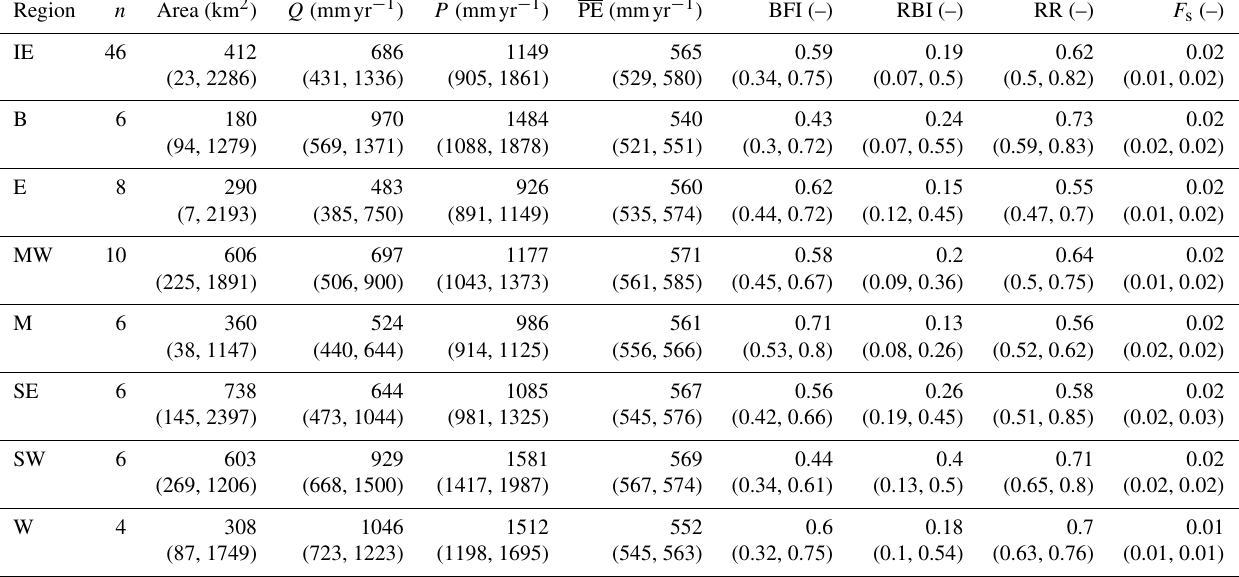
Table 2. Summary statistics of eight catchment characteristics for Ireland and each NUTS III region. The median across n catchments is given with the 5th and 95th percentile ranges in parentheses. Mean annual runoff ( Q ), precipitation ( P ), and potential evaporation (PE)